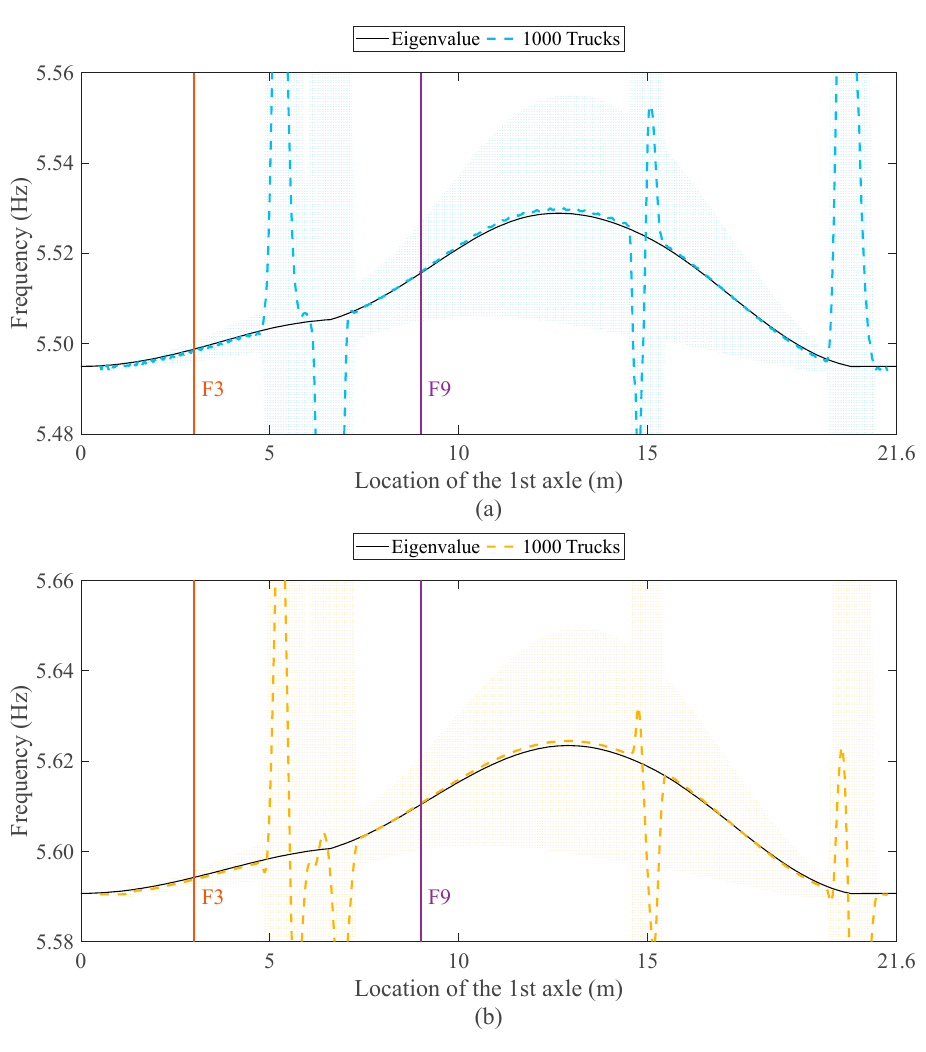
Hz. Figure 12b makes the same comparison for the 5% crack at 7 m. As expected, the fre- quency range, [5.58, 5.66] Hz, is different for this second scenario, but the overall pattern